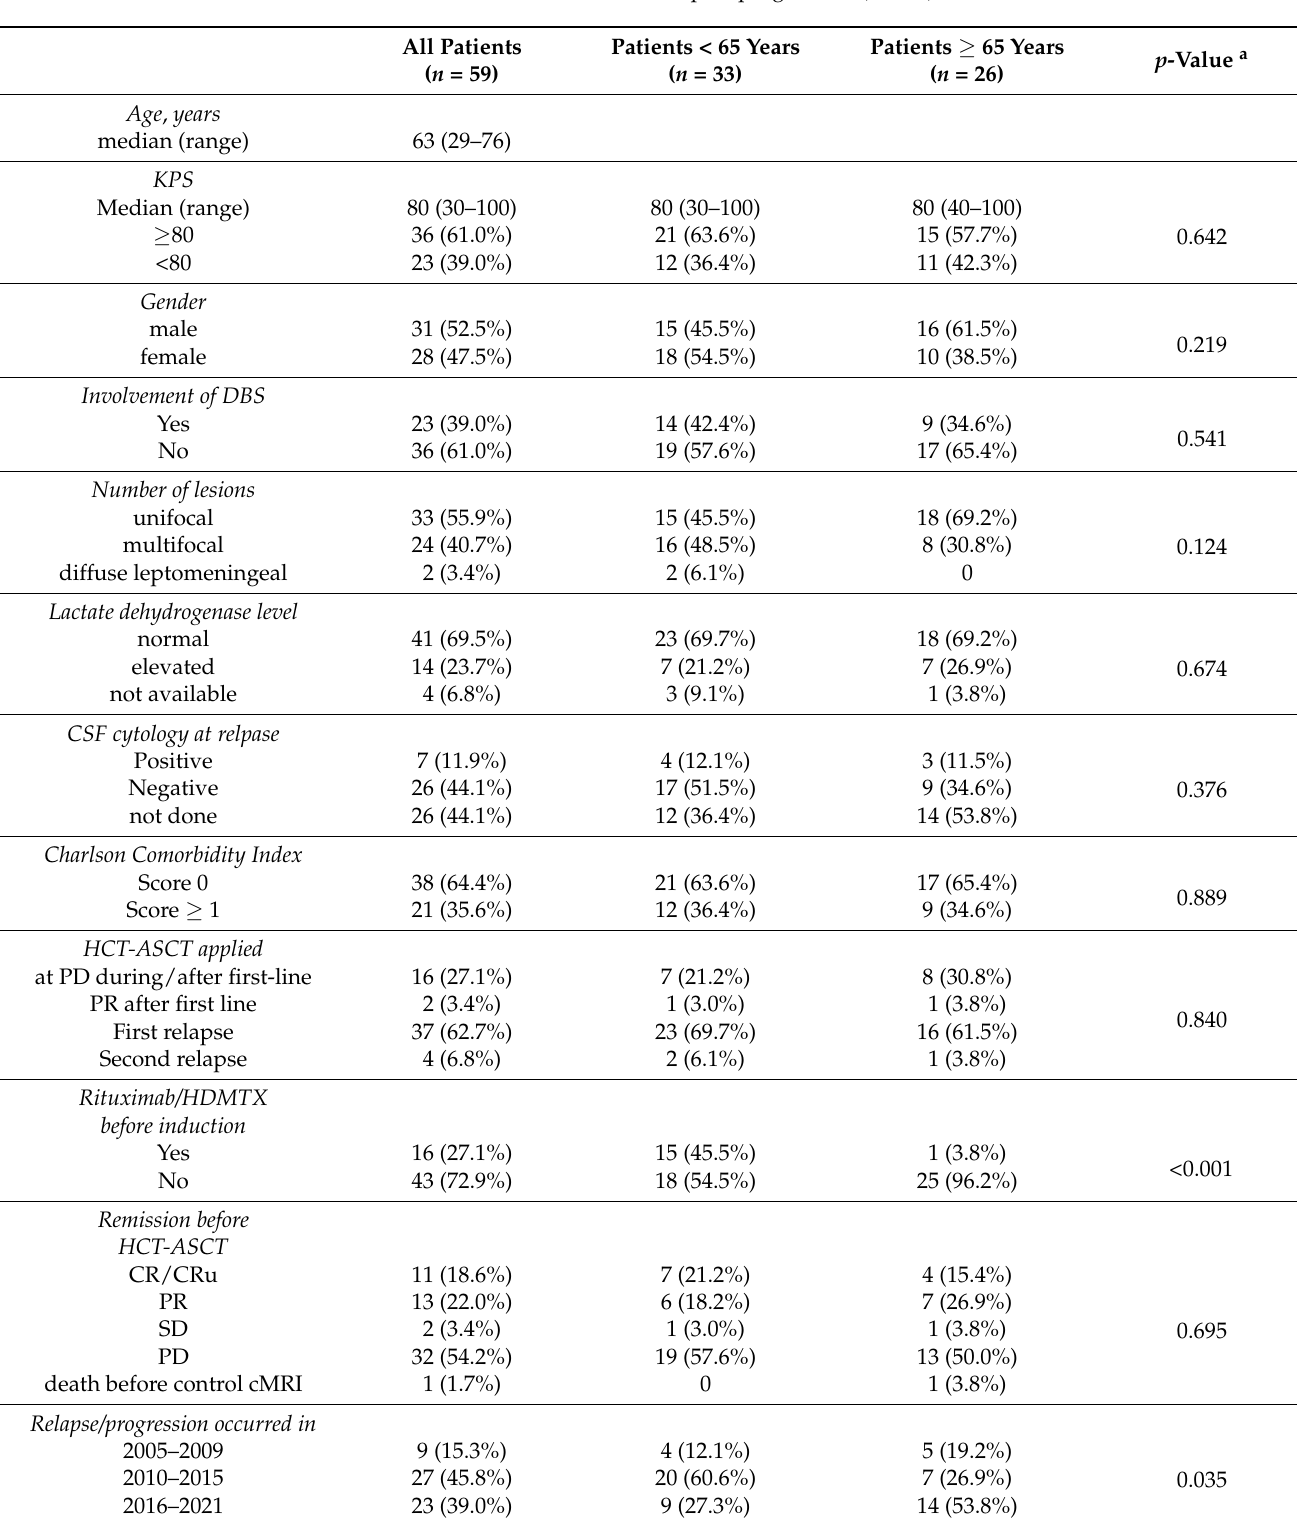
Table 1. Patient characteristics at relapse/progression ( n =